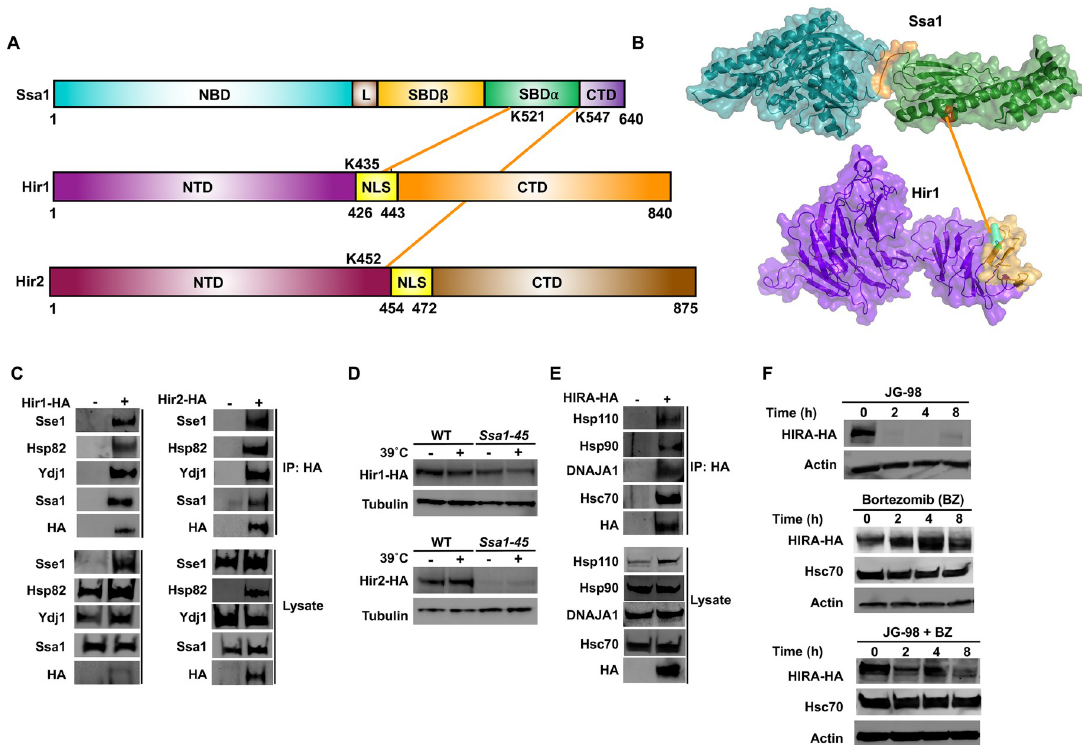
Fig 4. HIR complex is a novel client of Hsp70 in yeast and humans. (A) Schematic representation of Ssa1-Hir1/Hir2 inter protein cross-links detected on SBD of Ssa1 and NLS of Hir1 and NTD of Hir2. (B) Ssa1-Hir1/2 cross-links mapped on the crystal structure of Ssa1, Hir1, and Hir2. (C) The Hir complex interacts with yeast chaperones. (D) Hir1 and Hir2 are dependent on Ssa1 for their stability. Indicated yeast cells were transformed with plasmids expressing HA-Hir1 or HA-Hir2 driven via the GAL1 promoter. Yeast were grown to mid-log in YPGalactose-URA media and then were either left untreated or were exposed to heat shock at 39˚C for 90 min. Levels of Hir1 or Hir2 were assessed via western blot using antisera to indicated proteins. (E) HIRA interacts with chaperone complexes in mammalian cells. HEK293 cells were transfected with an HA-HIRA construct. After 24 h, total protein was extracted and HIRA complexes were purified via HA-magnetic beads. The purified HIRA complexes were analyzed by SDS-PAGE followed by western blotting using the indicated antisera. (F) Western blot analysis of HIRA upon addition of Hsp70 inhibitor JG-98 and proteasomal inhibitor bortezomib. CTD, C-terminal domain; HIR, histone regulator; NBD, nucleotide-binding domain; SBD, substrate-binding